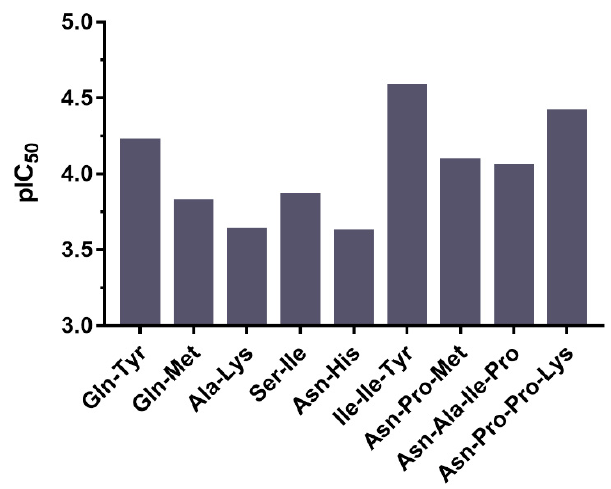
Figure 4. pIC 50 values of nine new ACE inhibitory peptides from Todarodes pacificus .